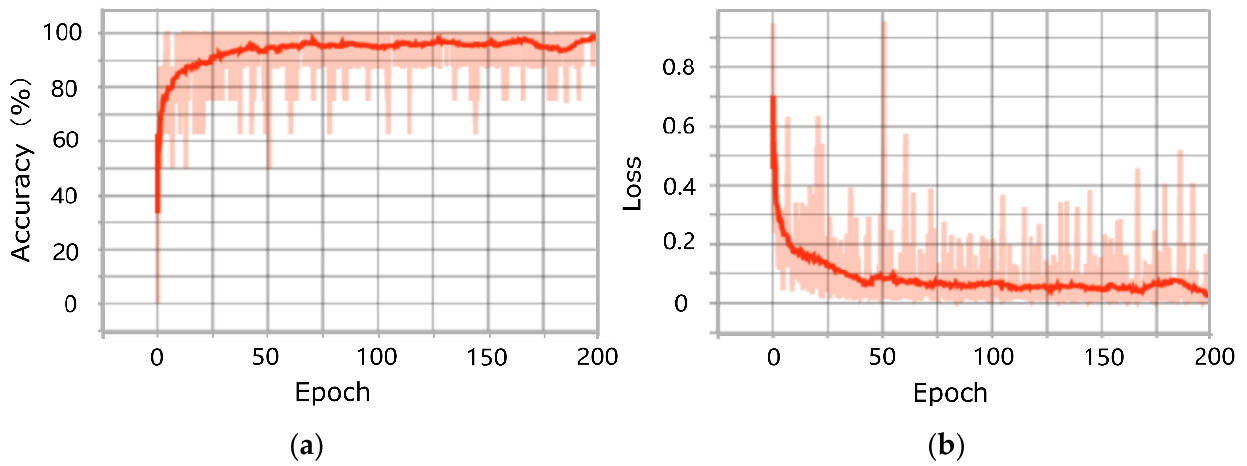
Figure 6. ( a , b ) are the curves of training accuracy value and training loss value of PointNet for tree recognition from input voxels. Fluctuations in the light colored region were caused by repeatedly learning effective features from complicated samples in a batch to identify whether the voxel is a tree, but the overall upward trend and the downward trend of the curve indicates a better convergence result of training.